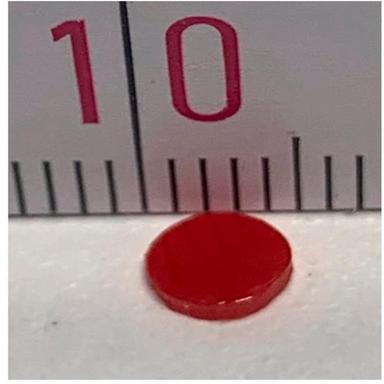
Red-colored TPU sample prepared by the use of a punching plie. (For interpretation of the references to color in this figure legend, the reader is referred to the Web version of this article.)